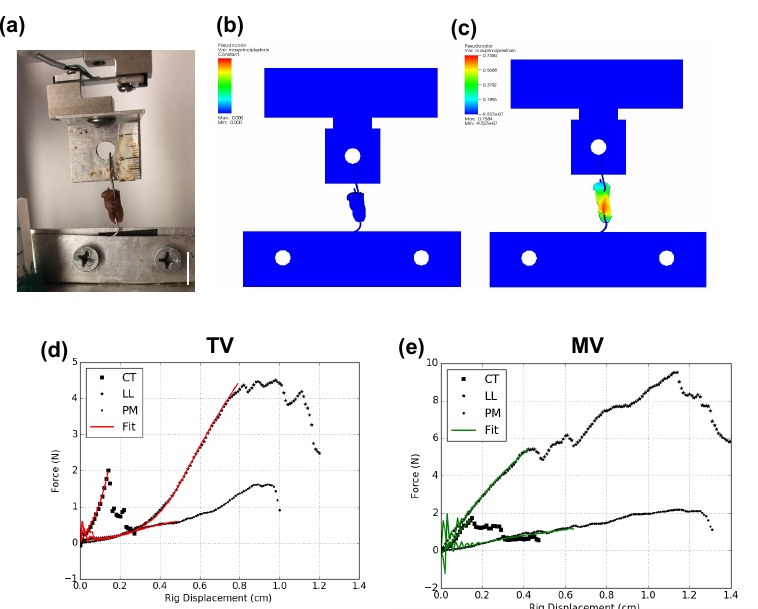
Figure 5. Uniaxial tension tests to characterize “pure” tissue specimens. ( a ) PM tissue in TV under uniaxial tension test, ( b ) corresponding virtual matched pair test, ( c ) strain distribution in specimen, ( d ) force–displacement data for CT, LL and PM in TV specimens with their overlaid fits and ( e ) force–displacement data for CT, LL and PM specimens in MV with overlaid fits. Scale bar in ( a ) represents 15